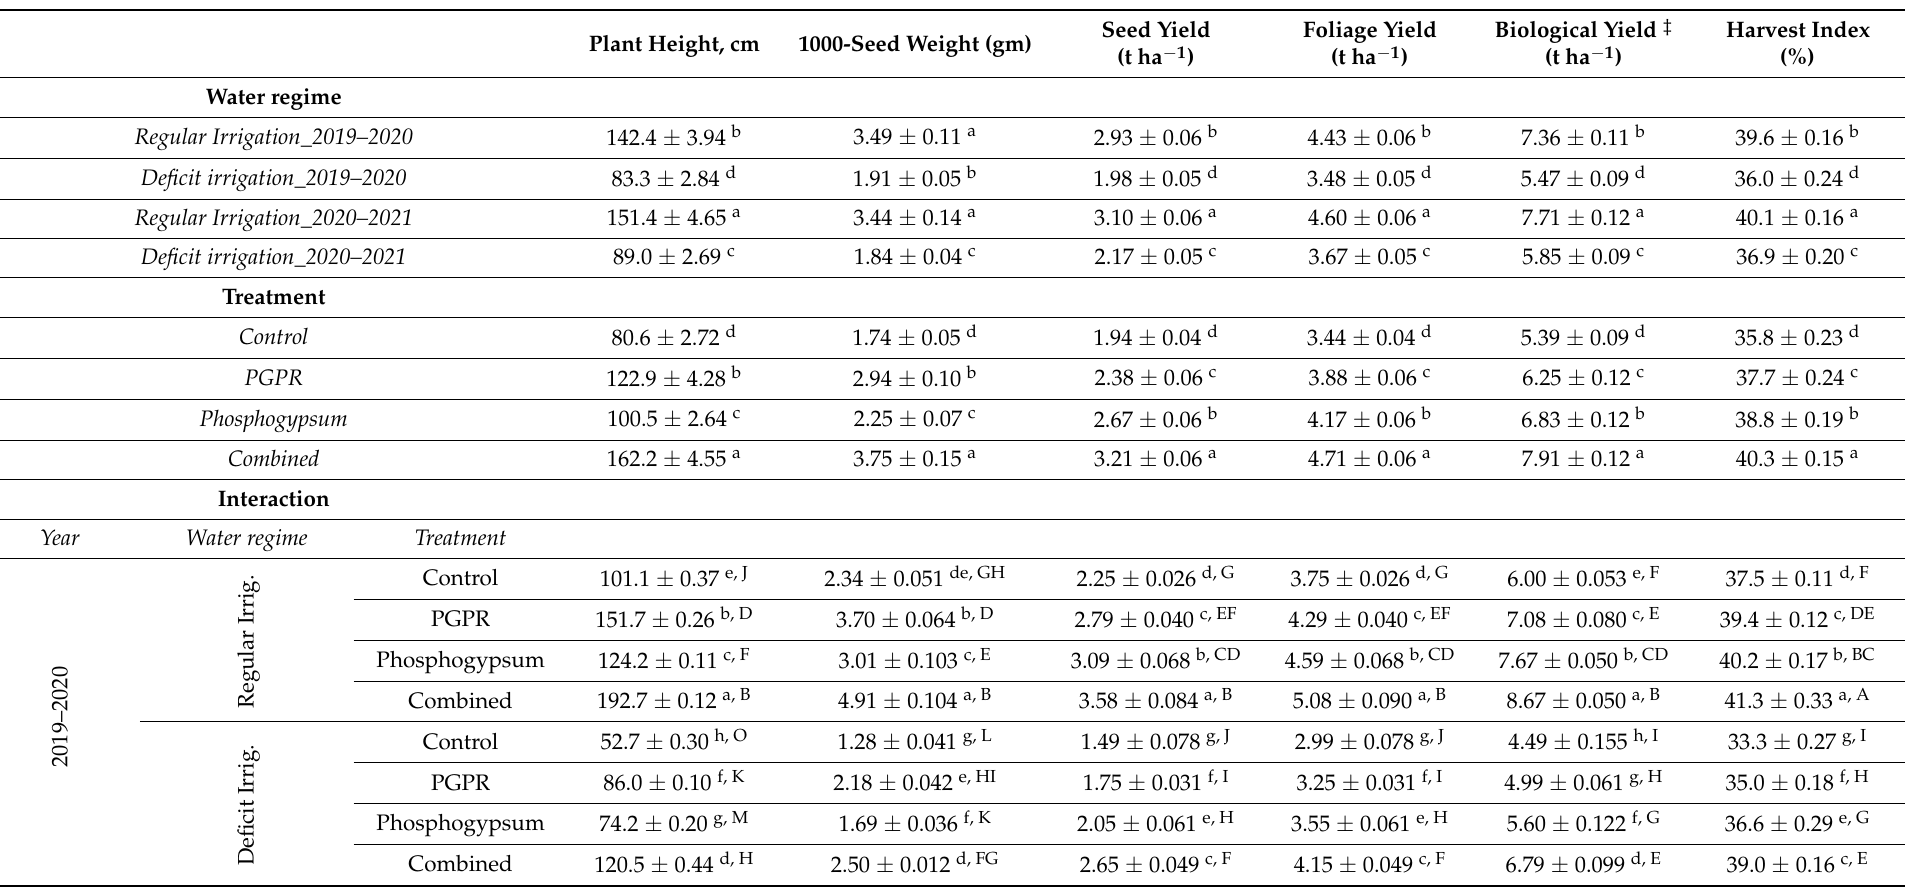
Table 4. Yield and yield components of quinoa plants grown in the presence of different water regimes and treated with phosphogypsum, plant growth-promoting rhizobacteria, or